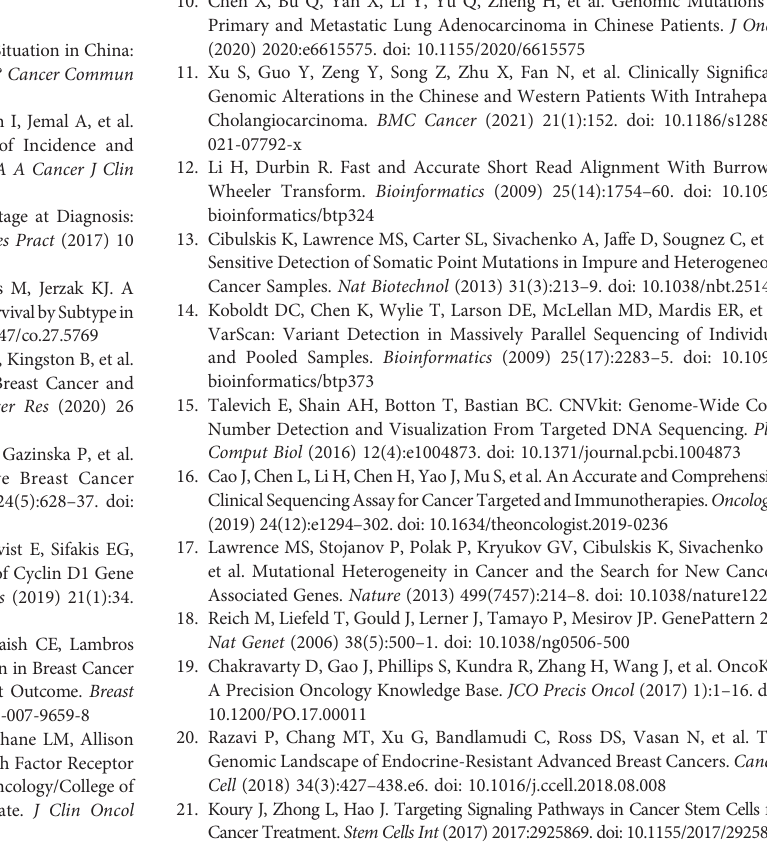
Supplementary Figure 2 | Comparison of gene mutations with MSK cohort. Top mutated genes are compared between the patients with the subtypes of Luminal (A) , HER2_enriched (B) , and TNBC (C) in this study. In the MSK cohort, the difference between ER (D) , PR (E) , and HER2 (F) statuses are also shown. And top mutated genes are compared between the patients with the subtypes of Luminal (G) , HER2_enriched (H) , and TNBC (I) . *, adjusted P -value <0.05; **, adjusted P - value <0.01; ***, adjusted P >-value <0.001. Supplementary Figure 3 | The association between patient groups and breast cancer subtypes (Luminal, HER2, and TNBC). (A) The association between gene clusters and breast cancer subtypes is indicated with association scores. Associationscoresabovetheupperandbelowthelowerreddashedlinesindicatea positive and negative association with P -value<0.05, respectively. (B) Association between geneclusters and breast cancer TNM stagingis indicated with association scores. Supplementary Figure 4 | Deconstruct the signatures in the four groups of patients. The weights of COSMIC (Catalogue Of Somatic Mutations In Cancer) signatures are deconstructed from somatic mutations in the four patient groups using an R package “ deconstructSigs ” . There are 30 COSMIC signatures (v2.0). The relative importance of signatures is shown with a pie plot for the patient group 1 (A) , 2 (B) , 3 (C) , and 4 (D) . A larger area indicates higher importance. Supplementary Figure 5 | The association between patient groups and clinical characteristics in the MSK cohort. The association between gene clusters and clinical characteristics is indicated with association scores in the MSK cohort. Associationscoresabovetheupperandbelowthelowerreddashedlinesindicatea positive and negative association with P -value<0.05, respectively. Supplementary Table 1 | The gene list of sequencing